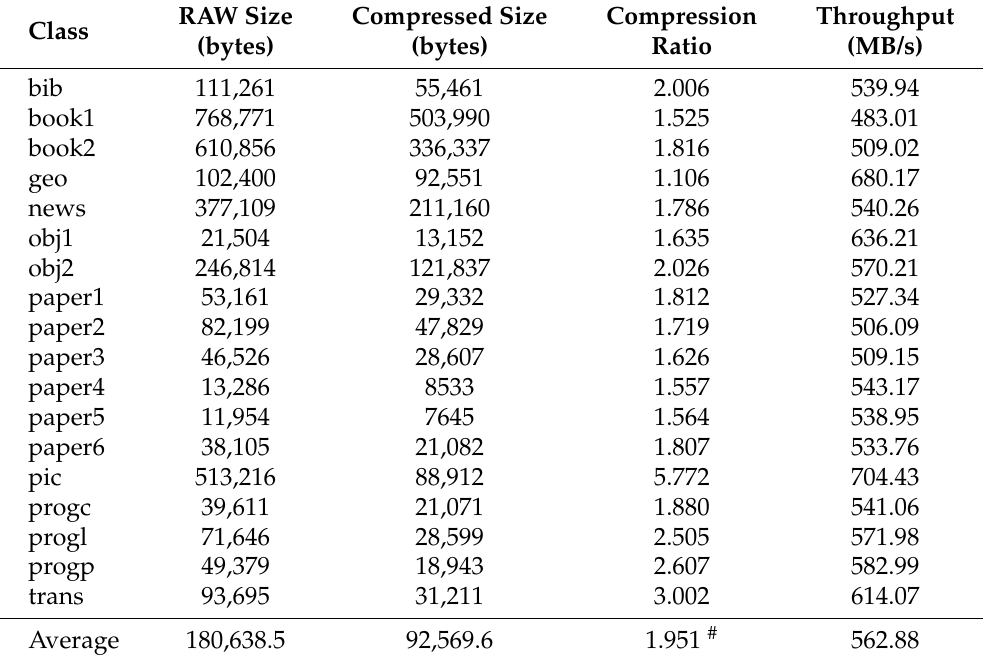
Table 3. The compression kernel performance of HybriDC evaluated on the Calgary